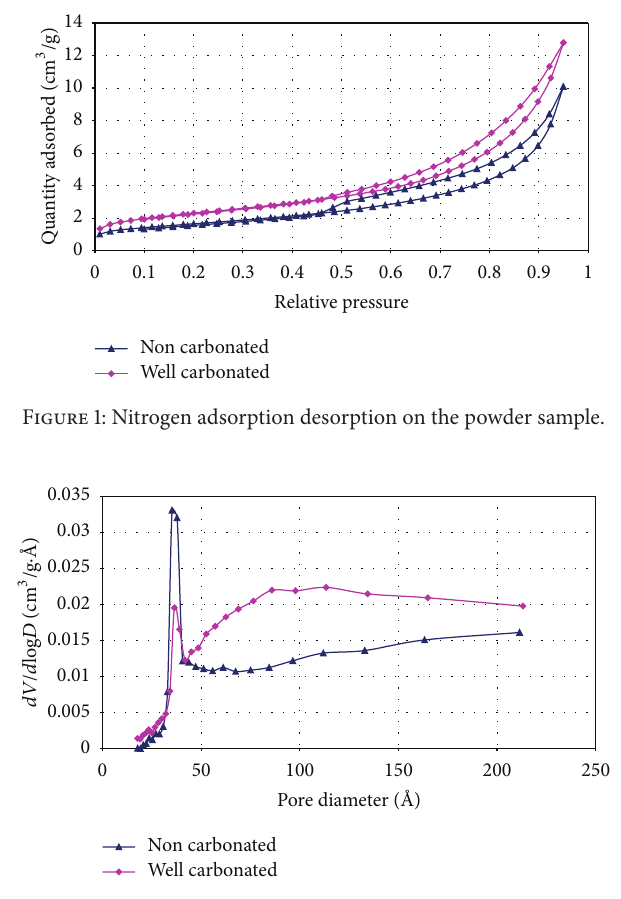
Figure 2: Pore size distribution determined from nitrogen desorp- tion branch of the powder sample.